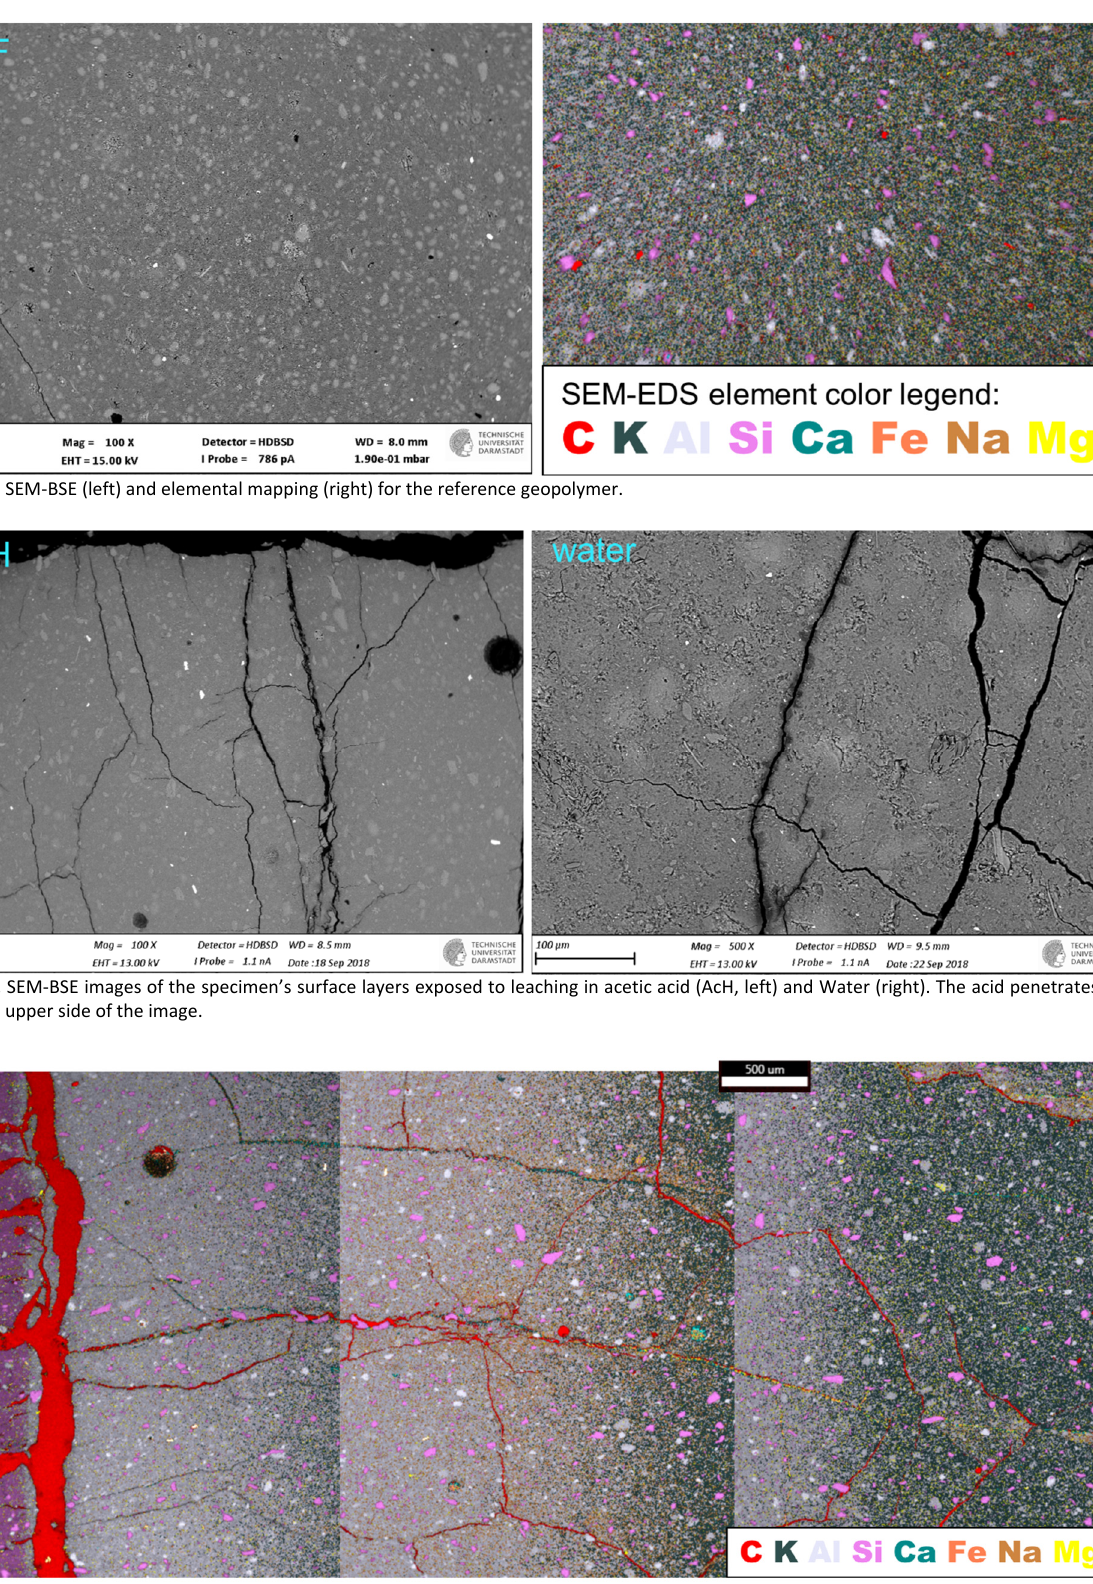
Figure 7. A stack of three SEM ‐ EDS mapping images of the specimen’s cross sections for the analysis of elemental depth profiles. The left boundary of the image represents the specimen’s surface boundary section exposed to leaching in acetic acid. The element color legend is shown in right ‐ bottom corner of the